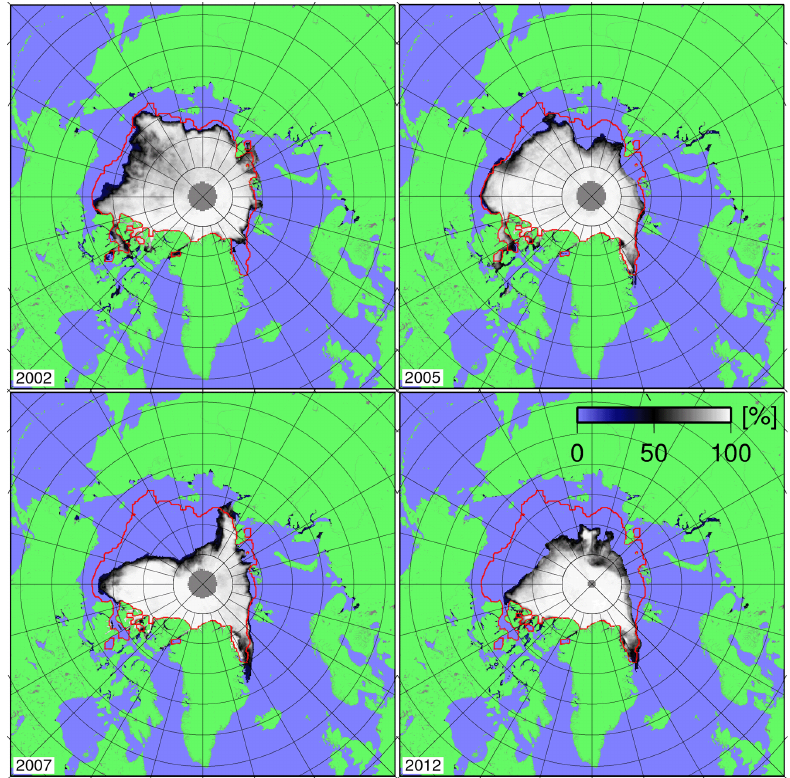
Figure 1. Monthly mean sea ice concentration (white to blue), based on SSM/I data for September 2002, 2005, 2007 and 2012, with the average ice margin (red) for the years 1992–2006. Pictures provided by Lars Kaleschke of the University of Hamburg. The SSM/I algorithms are described by Kaleschke et al.